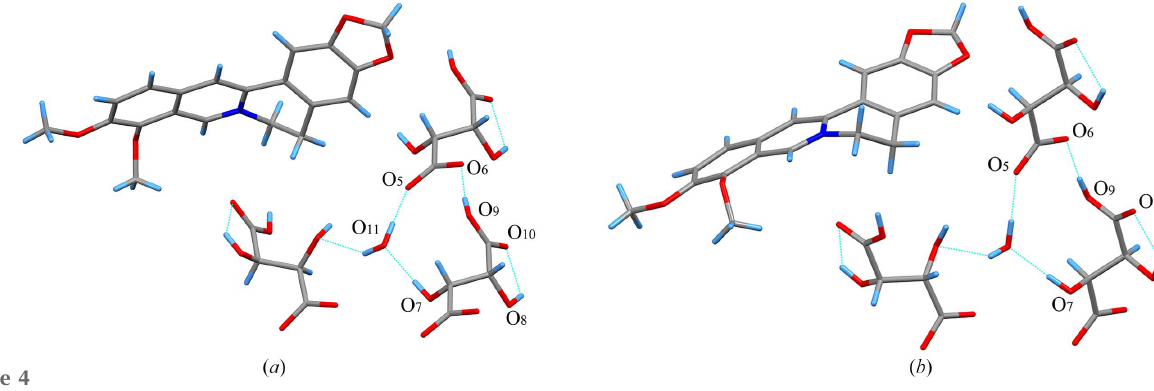
Figure 4 Hydrogen bonds between molecules in ( a ) 1BER-1 l -TA-1W and ( b ) 1BER-1 d TA-1W.